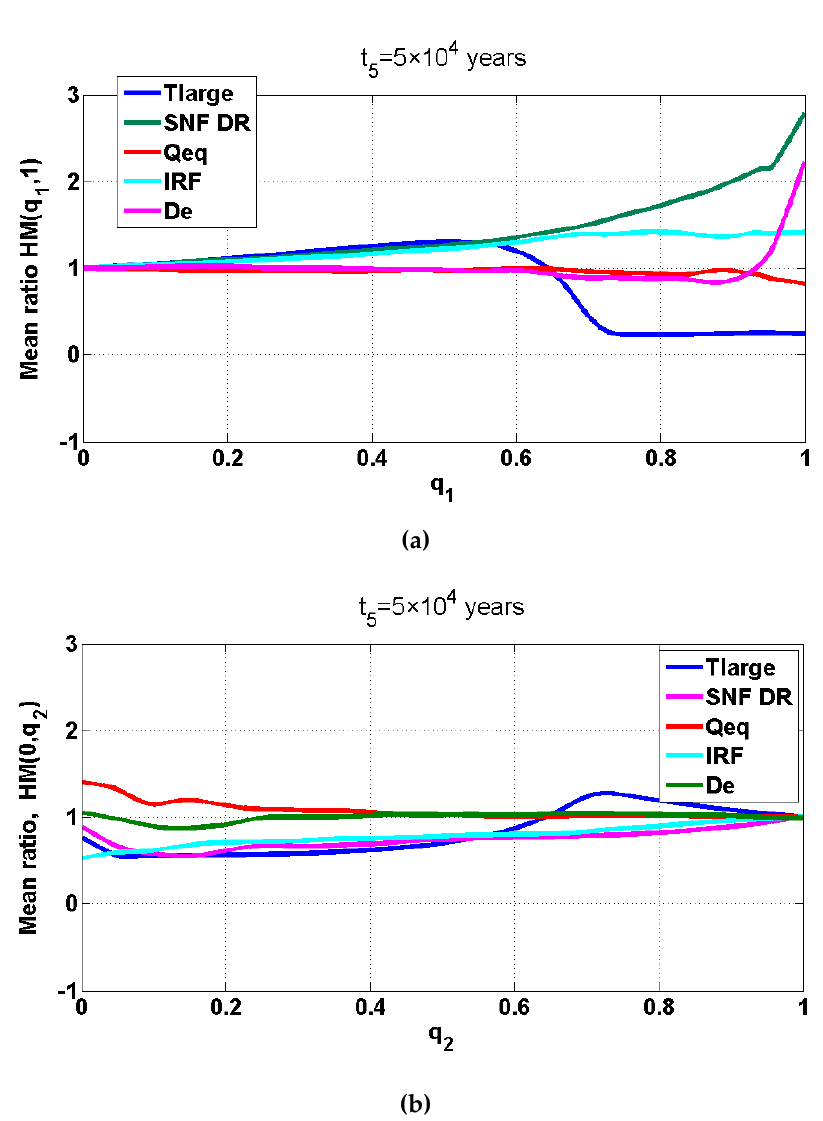
Figure 9. The mean ratio functions (HM) due to ( a ) reduced upper bound and ( b ) increased lower bound of the range of parameters (Tlarge, SNF DR, Qeq, IRF, De) at t 5 = 5 × 10 4 years after repository closure (smoothed by the regression technique) (Tlarge—defect size enlargement time, SNF DR—SNF matrix dissolution rate, Qeq—equivalent groundwater flow rate around the canister, IRF—instant release fraction, De—e ff ective di ff usivity of I-129 in